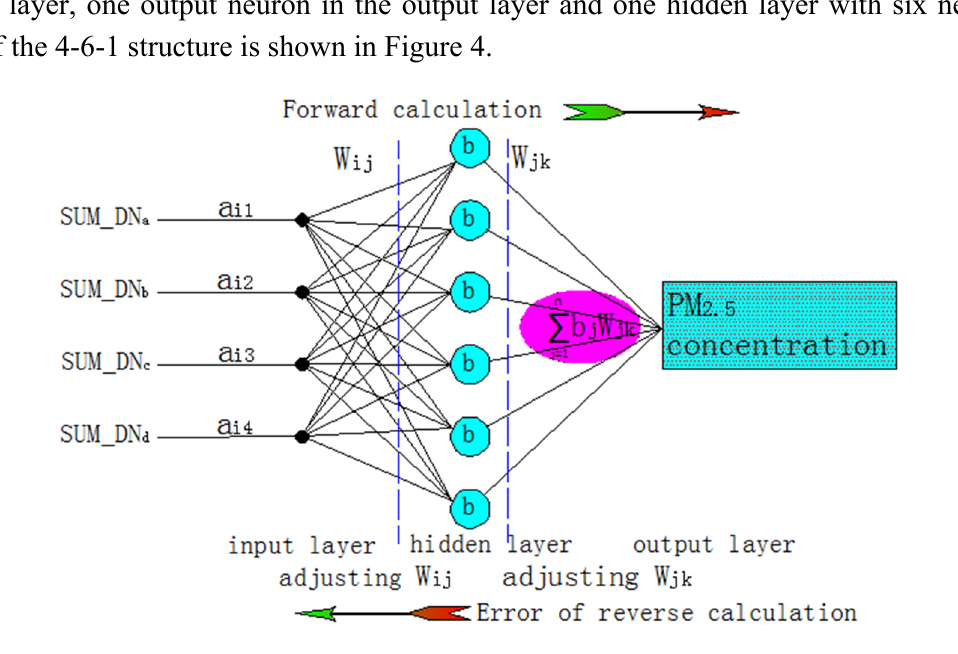
Figure 4. The 4-6-1 topological structure of the BP neural-network